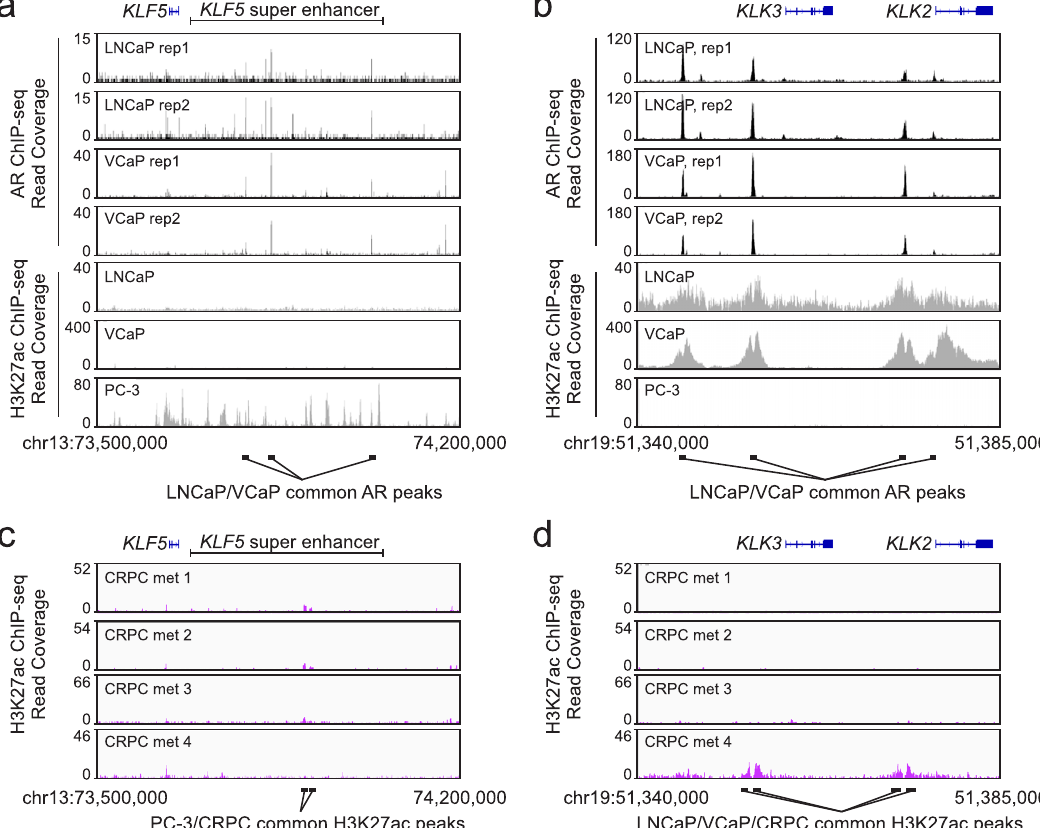
Fig. 3 The KLF5 and KLK2/3 super-enhancers display an inverse pattern of H3K27ac activation marks. a , b Gene track views of H3K27ac and AR ChIP- seq data from AR-positive LNCaP and VCaP cell lines and the AR-negative PC-3 cell line at genomic loci for KLF5 and KLK2 / KLK3 . c , d Gene track views of H3K27ac from four clinical CRPC specimens at genomic loci for KLF5 and KLK2 / KLK3 . H3K27ac track heights were set using H3K27ac density at housekeeping gene enhancers shown in Supplementary Fig.